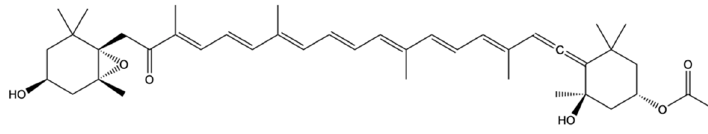
Figure 2. Chemical structure of the fucoxanthin .